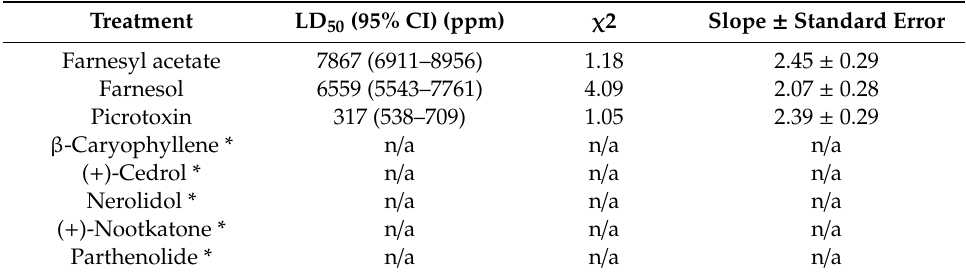
Table 1. Susceptibility of red palm weevils to di ff erent sesquiterpenes.